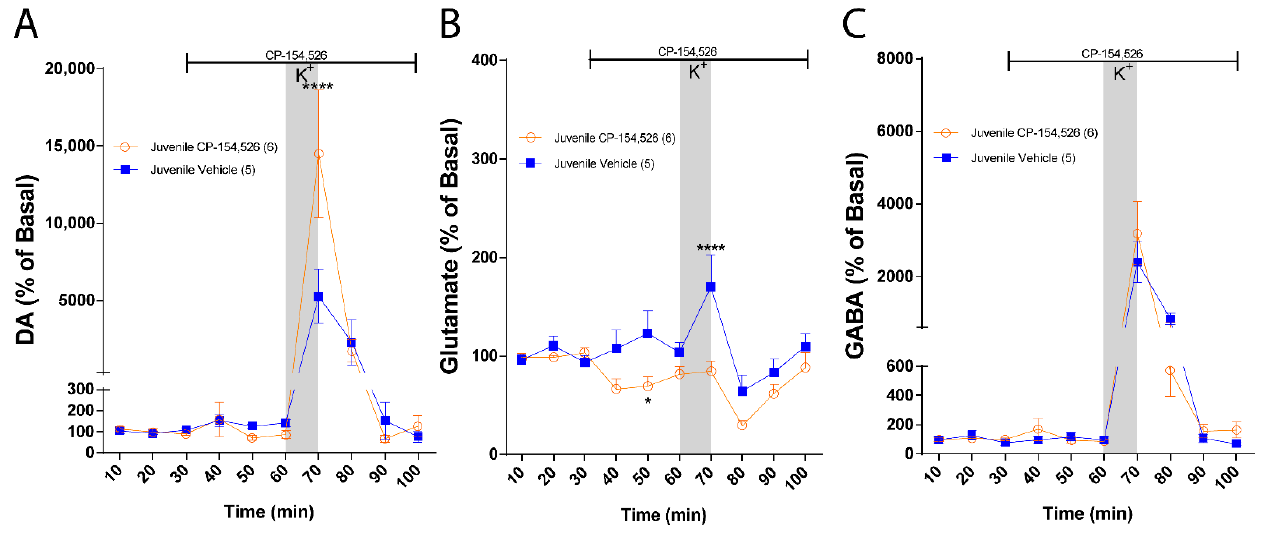
Figure 1. CRF-R1 modulates neurotransmitter levels in NAc of juvenile rats. Measurement of NAc extracellular neurotransmitter levels using in vivo microdialysis, the vertical gray bar indicates the time of NAc local infusion of 70 mM K+-aCSF, and the horizontal black lines indicate the time of intra-NAc infusion of the antagonist or vehicle. ( A ) NAc DA levels in the presence of aCSF (blue; n = 5) and 10 µM of CP154,526 (orange; n = 6). DA levels were normalized to the average of the first 3 values for each condition and expressed as a percentage. Two-way ANOVA revealed no effect of treatment (F (1, 9) = 2.019, p = 0.1890), a main effect of time (F (9, 81) = 15.25, p < 0.0001), and treatment × time interaction (F (9, 81) = 3.491, p = 0.0011; **** p < 0.0001, CP154,526 vs. aCSF, Bonferroni post hoc test). ( B ) NAc glutamate levels in the presence of aCSF (blue; n = 5) and 10 µM of CP154,526 (orange; n= 6). Glutamate levels were normalized to the average of the first 3 values for each condi- tion and expressed as percentage. Two-way ANOVA revealed a main effect of treatment (F (1, 9) = 5.639, p = 0.0416), a main effect of time (F (9, 81) = 8.349, p < 0.0001), and treatment × time interaction (F (9, 81) = 3.529, p = 0.0010; * p = 0.0394, **** p < 0.0001, CP154,526 vs. aCSF, Bonferroni post hoc test). ( C ) NAc GABA levels in the presence of aCSF (blue; n = 5) and 10 µM of CP154,526 (orange; n = 6). GABA levels were normalized to the average of the first 3 values for each condition and expressed as percentage. Two-way ANOVA revealed no effect of treatment (F (1, 9) = 0.2867, p = 0.6053), a main effect of time (F (9, 81) = 23.79, p < 0.0001), and no treatment × time interaction (F (9, 81) = 0.6012, p = 0.7925; n.s. p > 0.9999, CP154,526 vs. aCSF, Bonferroni post hoc test).